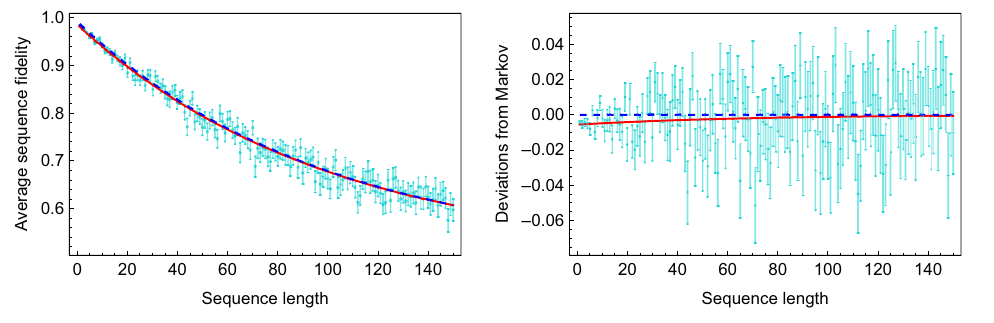
FIG. 13. RB non- Markovianity blindness on an XX -spin chain. Despite being generically non-Markovian, the noise model of Eq. (G2) displays virtually no deviations from a Markovian noise model when J = 1.2, J y = 2.7.